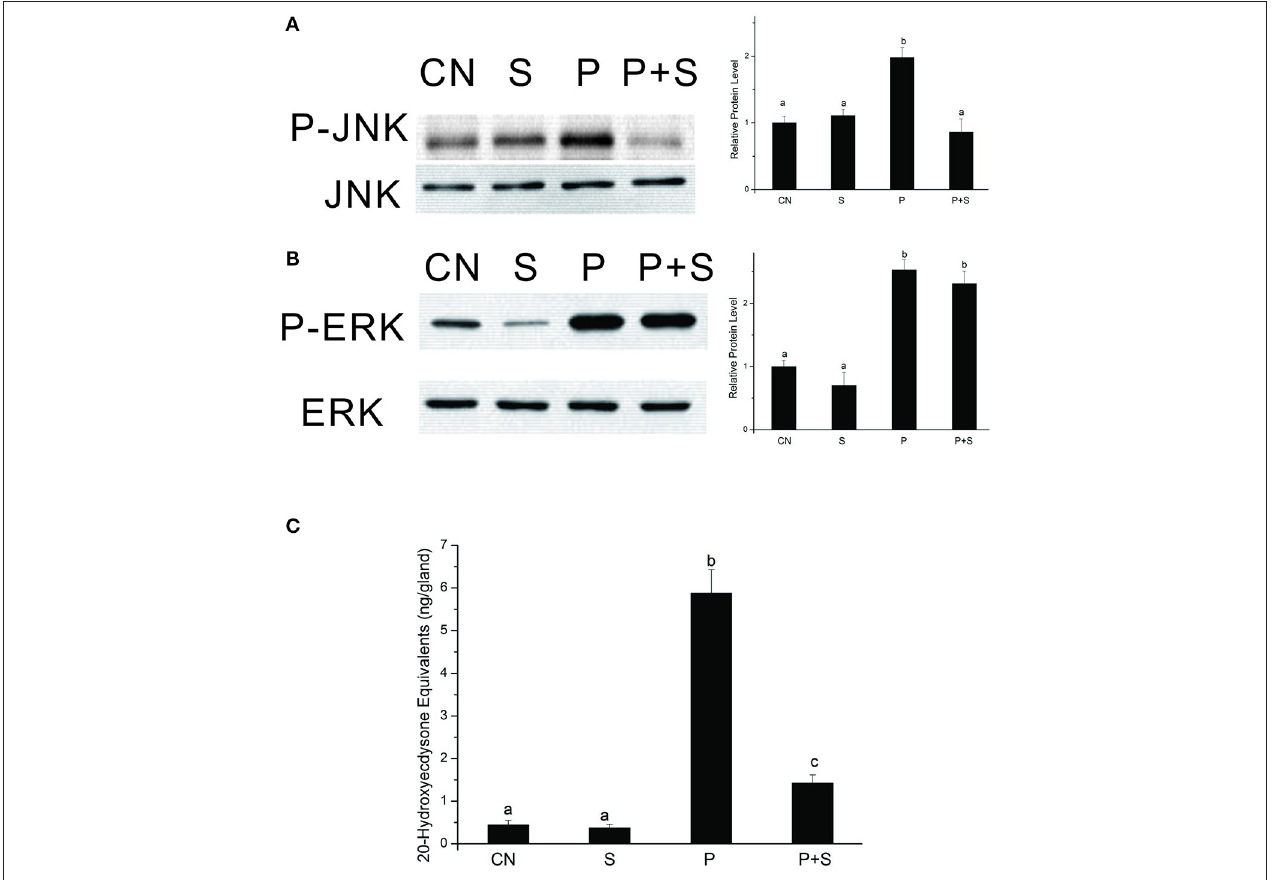
FIGURE 6 | Effects of SP600125 on PTTH-stimulated phosphorylation of JNK (A) and ERK (B) and ecdysteroid secretion (C) . PGs were pretreated with 20 µ M SP600125 or vehicle alone for 30min, and then transferred to medium containing the same dose of SP600125, with or without the PTTH. Incubation was maintained for 60min. Gland lysates were prepared and subjected to an immunoblot analysis with anti-phospho-JNK (P-JNK), anti-JNK (JNK), anti-phospho-ERK (P-ERK), and anti-ERK (ERK) antibodies. CN, glands incubated in control medium; S, glands incubated in medium containing 20 µ M SP600125 only; P, glands incubated in medium containing the PTTH only; P + S, glands incubated in medium containing both the PTTH and 20 µ M SP600125. Results shown in the left panels (for A,B ) are representative of three independent experiments. Data are expressed as multiples of change over the respective control after being normalized to the level of JNK (for A ) or ERK (for B ). Ecdysteroid released into the medium was determined by an RIA. Different letters above the bars indicate a significant difference (ANOVA followed by Tukey’s multiple-comparisons test, p <